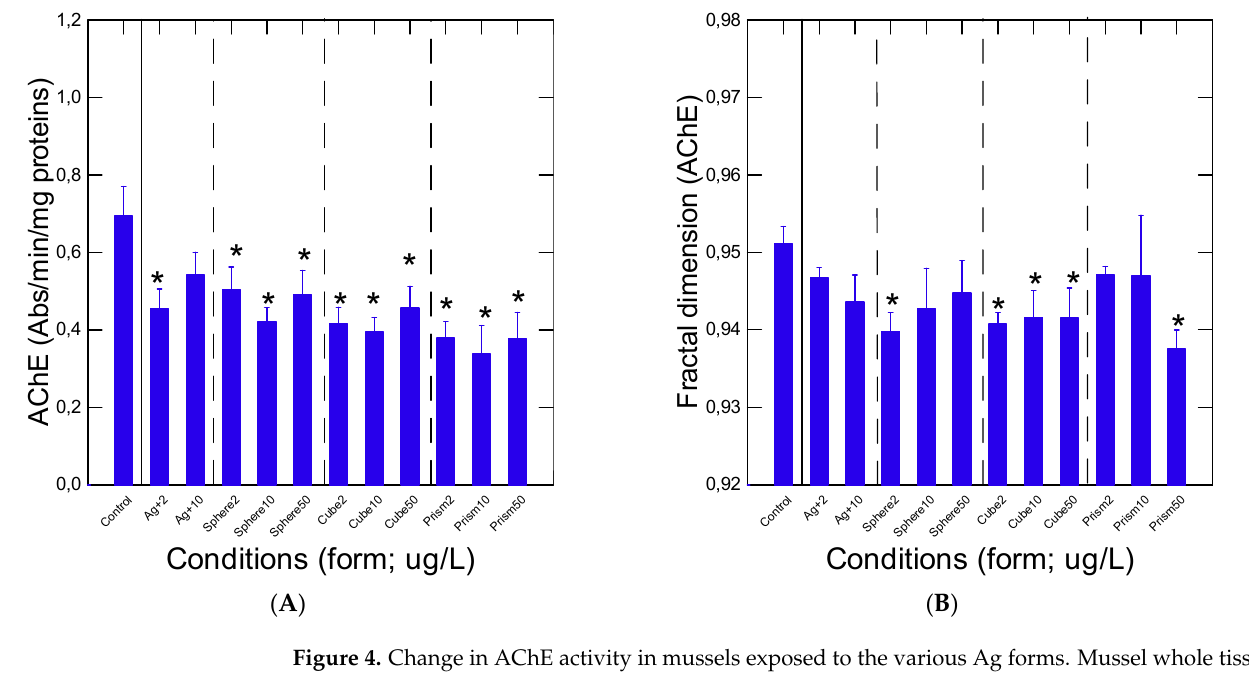
Figure 4. Change in AChE activity in mussels exposed to the various Ag forms. Mussel whole tissue homogenate fractions were isolated and analyzed for AChE activity ( A ) and the fractal dimension of AChE ( B ). The data represent the mean with the standard error. The star symbol * indicates significant differences from controls.